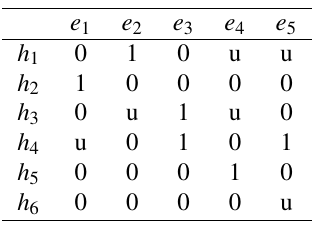
Table 2. II-type tabular representation of an interval soft set ( F , E )